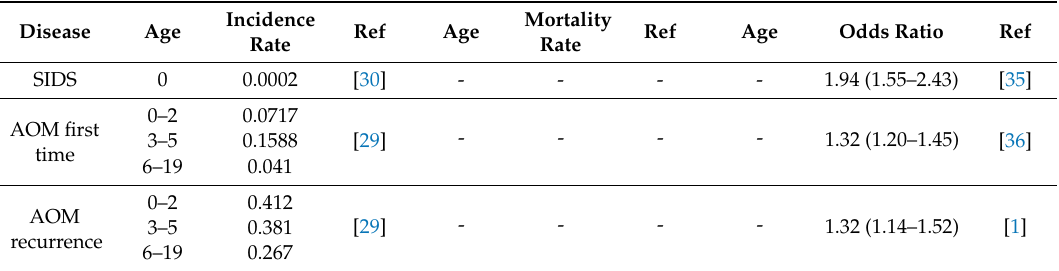
Table 2. Annual incidence / mortality rate per disease state of patients who were not exposed to SHS and the odds ratio of morbidity related to SHS exposure used in the